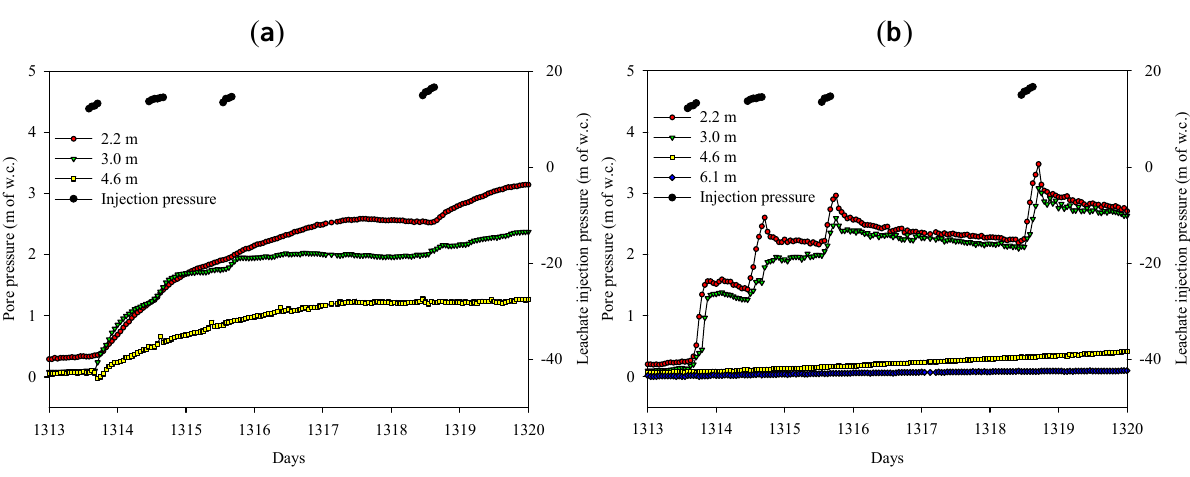
Figure 5. Piezometer responses to leachate recirculation in radial direction from the vertical well during the first few days of operation at an average flow rate of 13.67 × 10 − 4 m 3 /s. ( a ) Piezometers at a depth of 5.8 m from the surface of the landfill; ( b ) Piezometers at a depth of 14.9 m from surface of the